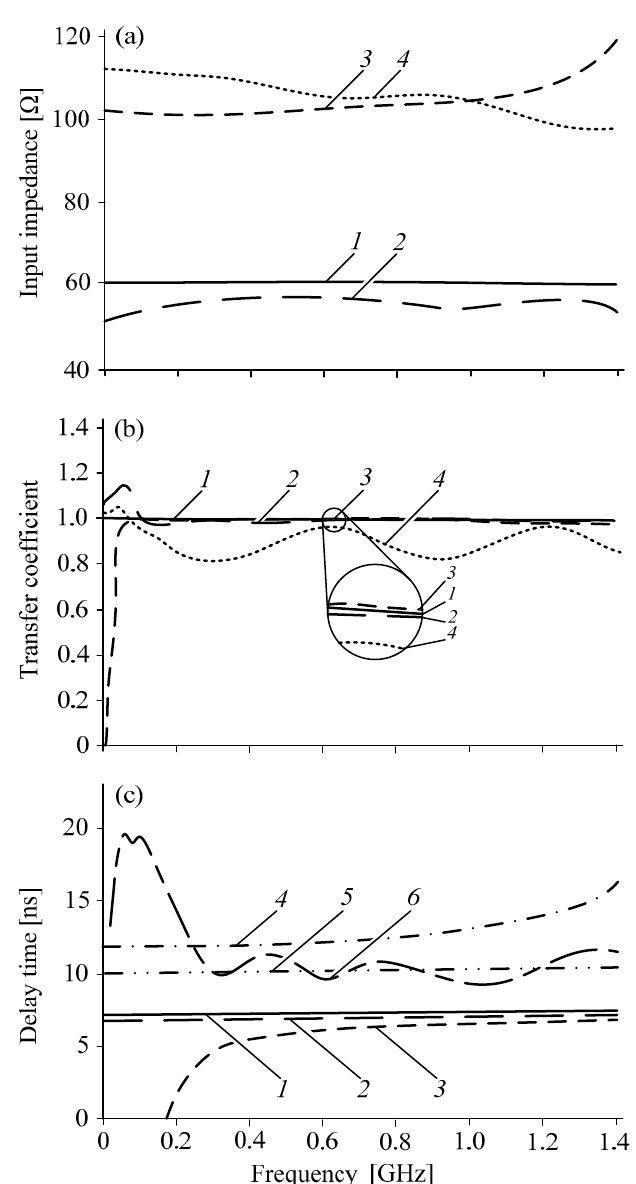
Figure 7. ( a ) The results of the input impedance characteristics: 1 = our developed algorithm, inductance was 0 nH [30]; 2 = Sonnet ® ; 3 = our developed algorithm, inductance was 5 nH [30]; 4 = Sonnet ® . ( b ) The characteristics of the transfer coefficient: 1 = CST Microwave Studio ® , inductance was 0 nH; 2 = Sonnet ® ; 3 = CST Microwave Studio ® , inductance was 5 nH; 4 = Sonnet. ( c ) The characteristics of the delay time: 1 = our developed algorithm, inductance was 0 nH [30]; 2 = CST Microwave Studio ® ; 3 = Sonnet ® ; 4 = our developed algorithm, inductance was 5 nH [30]; 5 = CST Microwave Studio ® ; 6 = Sonnet ® .